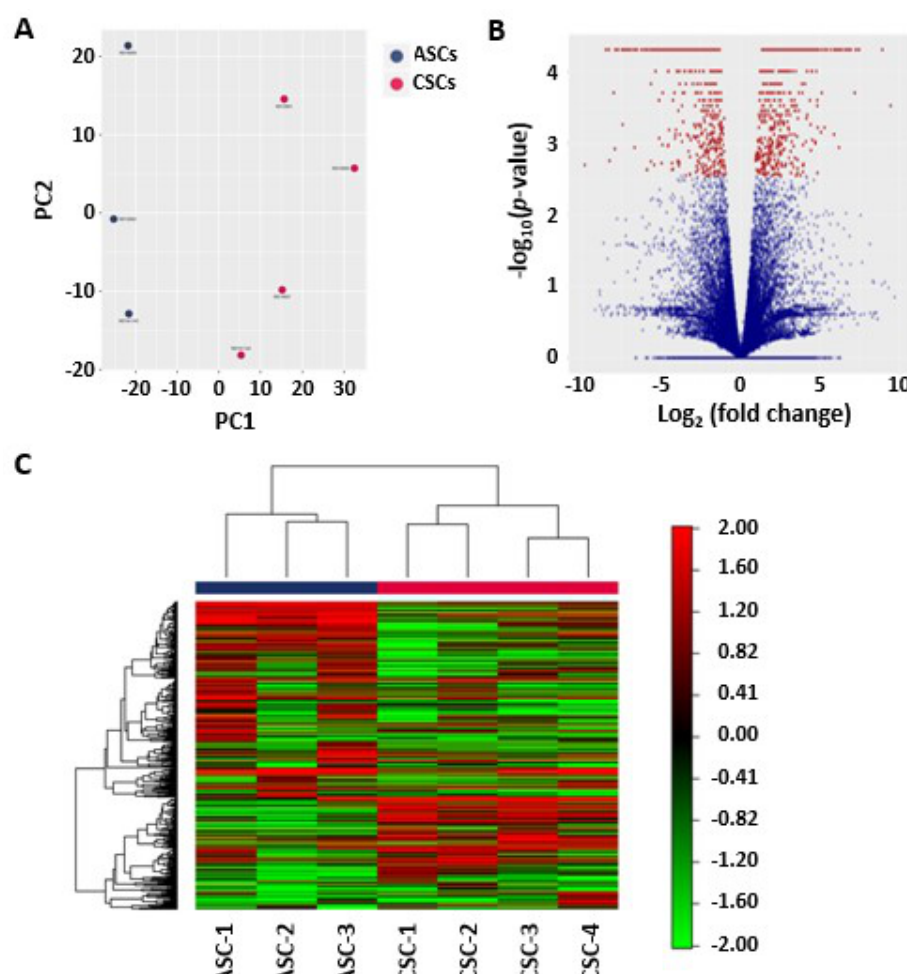
Figure 2. Differential expression patterns between ASCs and CSCs. ( A ) Principal component analysis (PCA) plot for ASCs and CSCs. The PCA was performed on all samples that passed the quality control using the 500 genes that had the largest coefficients of variation based on the fragments per kilobase of transcript per million mapped fragments (FPKM) counts. Each circle represents a sample. ( B ) Volcano plot showing the relationship between the raw p -values and the log2-fold change in normalized expression (FPKM) between ASCs and CSCs. ( C ) Heat map and unsupervised hierarchical clustering by sample and gene were performed on the listed samples using the 500 genes that had the largest coefficients of variation based on the FPKM counts. The data are based on samples from the ASC and CSC